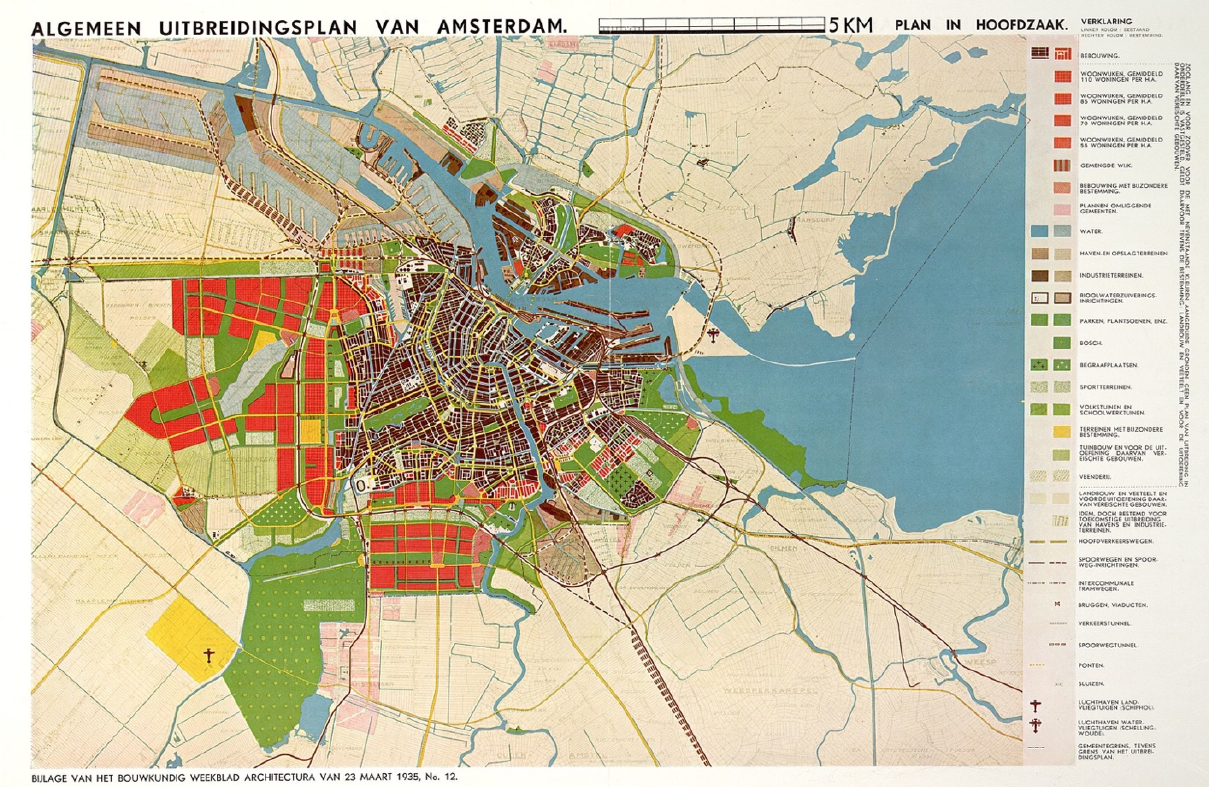
Figure 3. AUP of Amsterdam in 1935. Source: Amsterdam archive image bank. sign, the regularity of systems and the rectangular pat- terns (Hemel, 1994, p. 151).